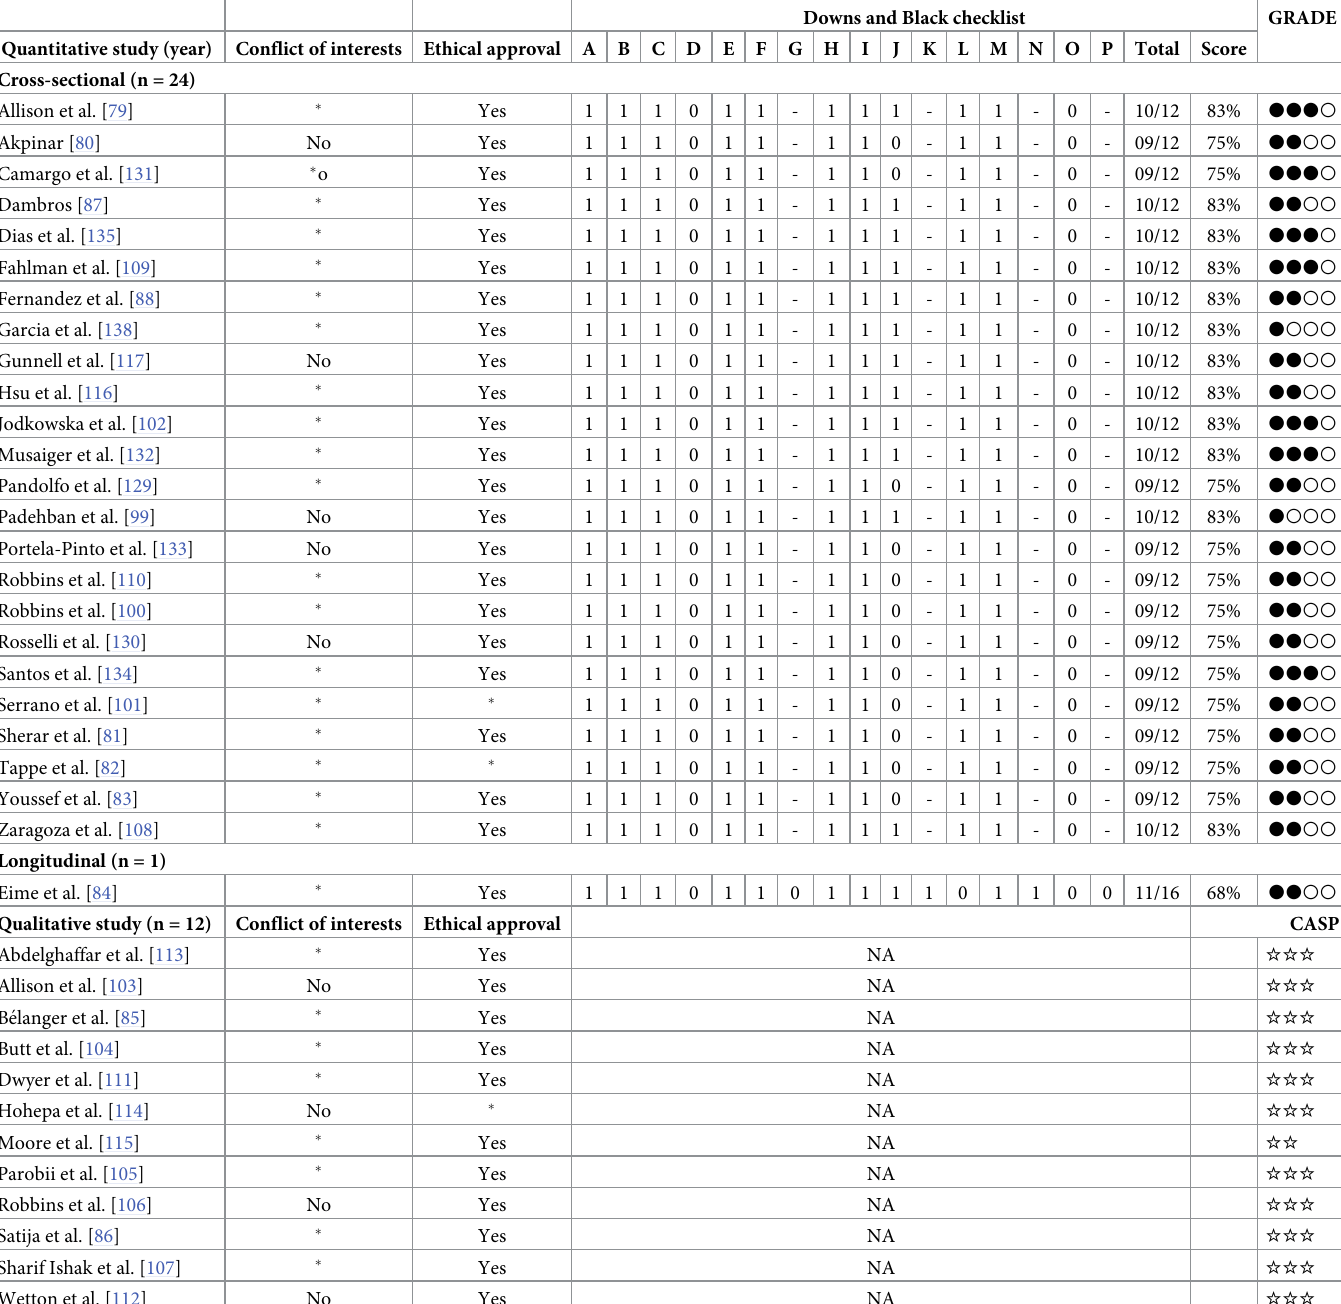
Table 5. Methodological quality and strength of evidence for studies examining barriers to physical activity in high school students. Downs and Black checklist